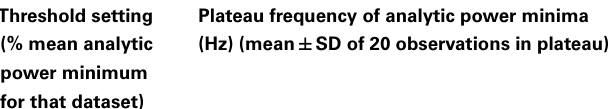
FIGURE 4 | Minima selected in segments of (A) waking and (B) postictally unconscious ECoG from the same subject. Threshold below which minima must fall in order to be counted (horizontal line) set at 30% of the mean amplitude for all minima in this dataset.